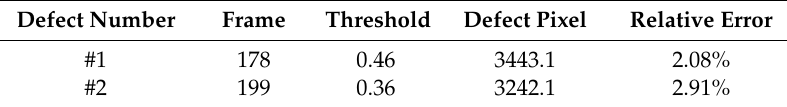
Figure 16. Defect extraction of primary detection: ( a ) ROI of defect #1 from Frame 178; ( b ) Segmentation of defect #1; ( c ) ROI of defect #1 from Frame 199; ( d ) Segmentation of defect #2; ( e ) Composition segmentation images as a whole. Table 2. Statistics of defect parameters using a single sensitive region.